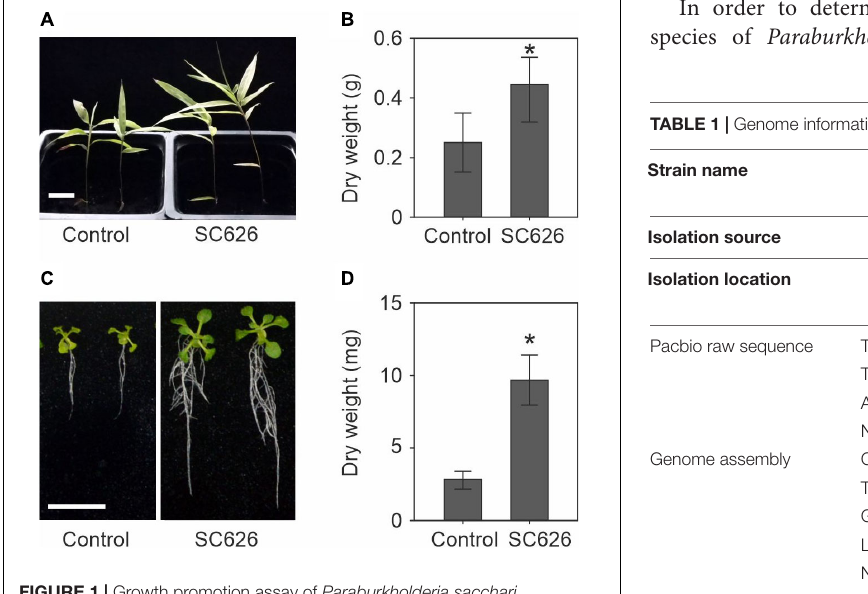
FIGURE 1 | Growth promotion assay of Paraburkholderia sacchari Suichang626 (SC626) on seedlings of moso bamboo and Arabidopsis thaliana . (A) Phenotype of 25-day-old bamboo seedlings in soil with or without P. sacchari Suichang626 inoculation. Bar = 1 cm. (B) Dry weight of moso bamboo seedlings from (A) . (C) Symptoms of 16-day-old Arabidopsis with or without P. sacchari Suichang626 inoculation. Scale bar = 1 cm. (D) Quantitative data of the dry weight of seedlings in (C) . All experiments were performed three times ( n = 8 in each biological repeat). *: significant difference ( P < 0.05).